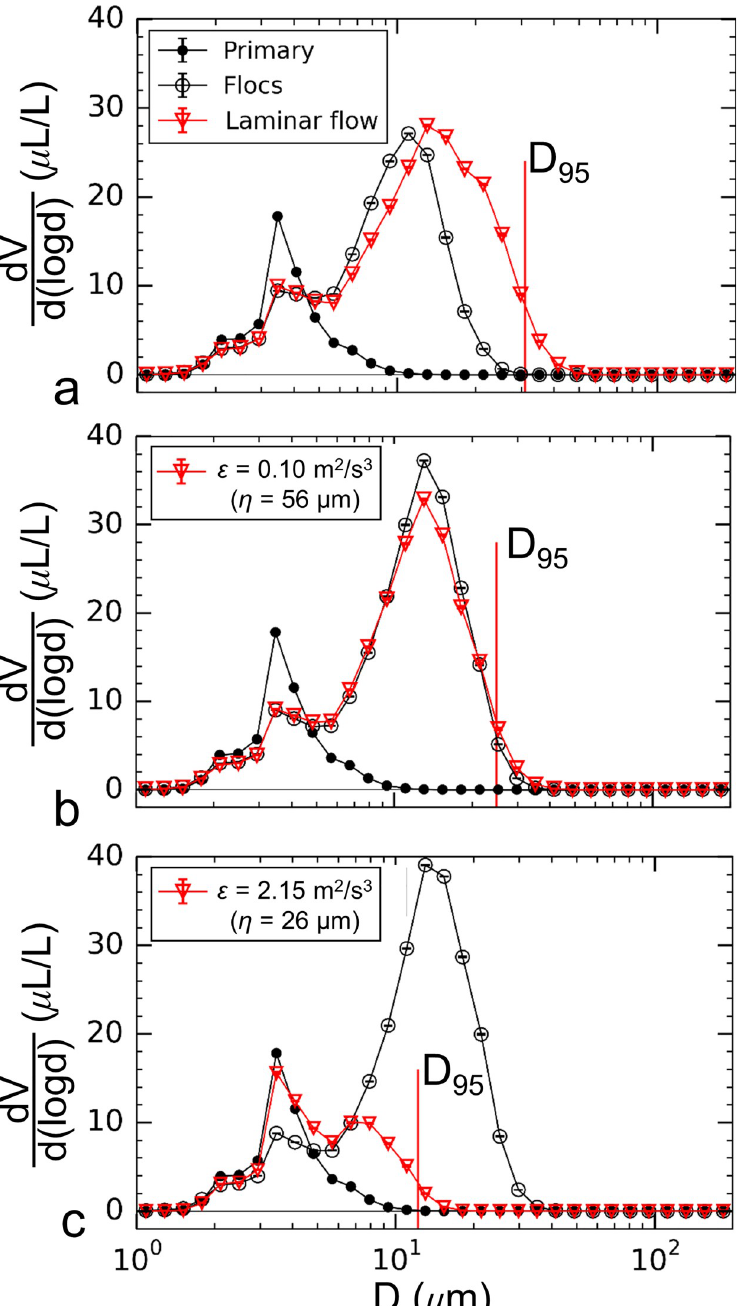
Fig 9. Size spectra of particle volume for the mixed aggregation tank conditions. Data is plotted for (a) laminar flow, (b) turbulent flow with ε = 0.10 m 2 /s 3 , and (c) turbulent flow with ε = 2.15 m 2 /s 3 conditions. Spectra for the primary particles, flocs in the aggregation tank, and flocs in the breakup tank are plotted in each